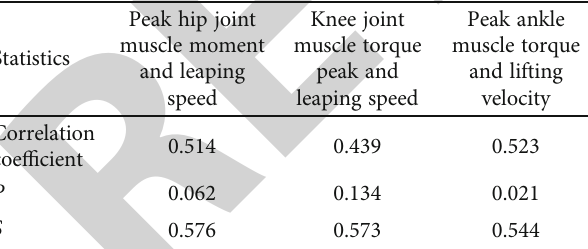
Table 3: Correlation analysis of take-o ff leg hip, knee, and ankle joint muscle torque peak and lift